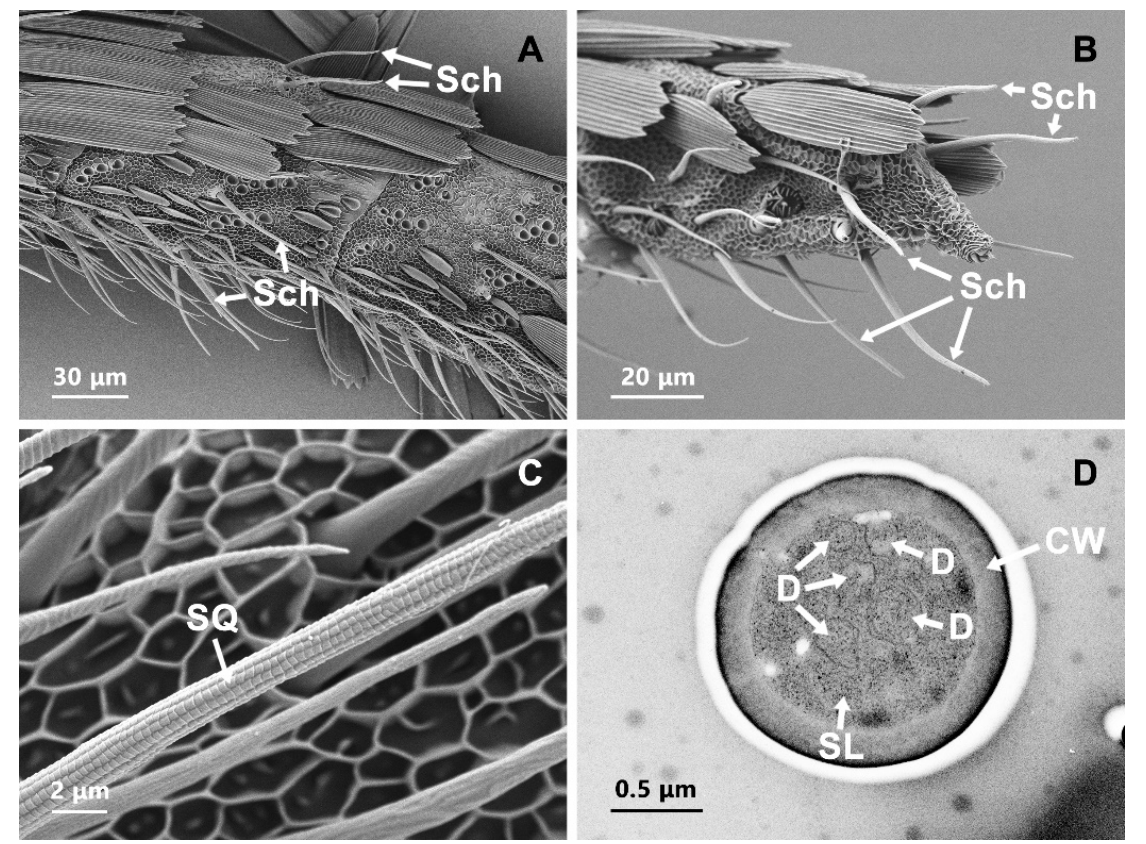
Figure 4. Scanning electron micrographs and transmission electron micrographs of sensilla chaetica (Sch). ( A ) Distribution pattern of Sch on flagellar segment. ( B ) distribution pattern of Sch on last flagellar segment. ( C ) the surface structure of Sch. ( D ) transverse section of Sch. CW: cuticle wall; D: dendrite; SL: sensilla lymph; SQ: squama.